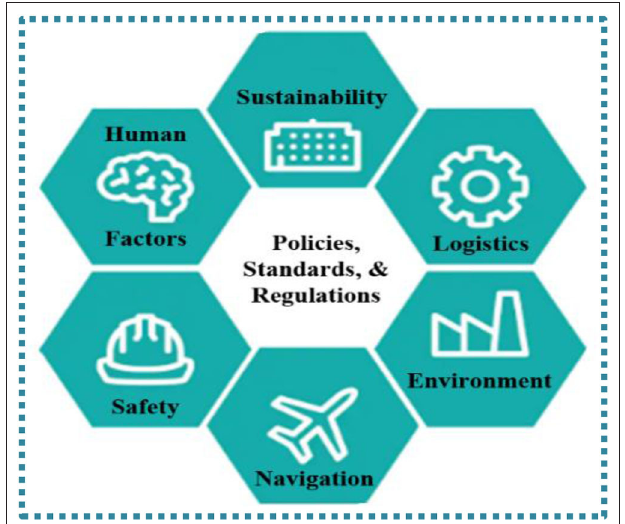
FIGURE 1 | Flying car M&S domains of interest. FIGURE 2 | Flying car drone dome